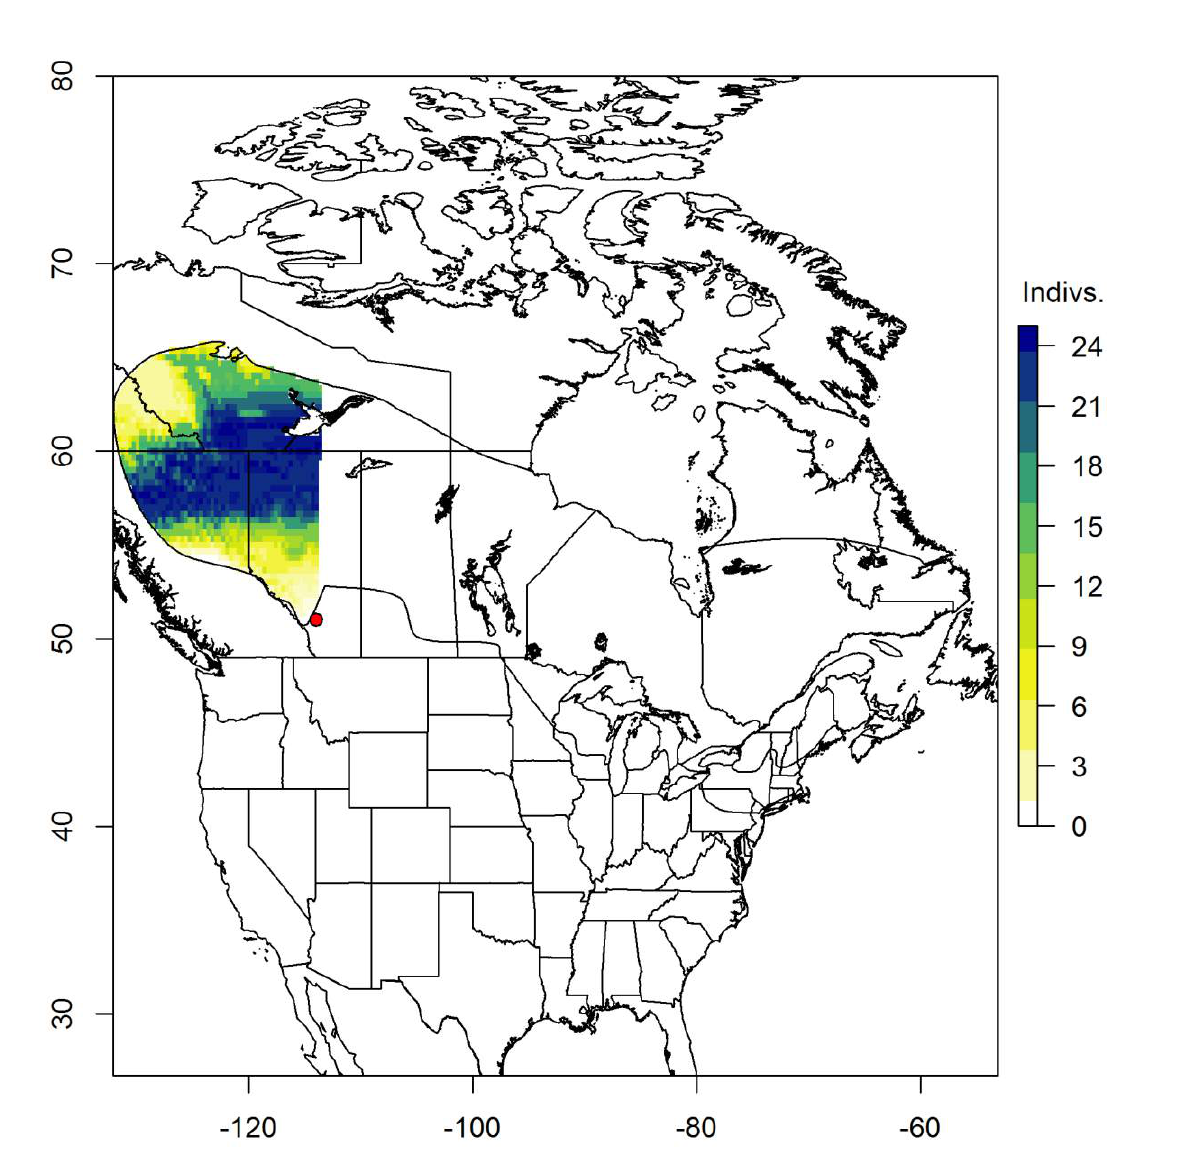
Figure A2.24: Probable origins of White-throated Sparrows ( Zonotrichia albicollis ) captured during fall migration at the IBS CMMN station in Southern Alberta